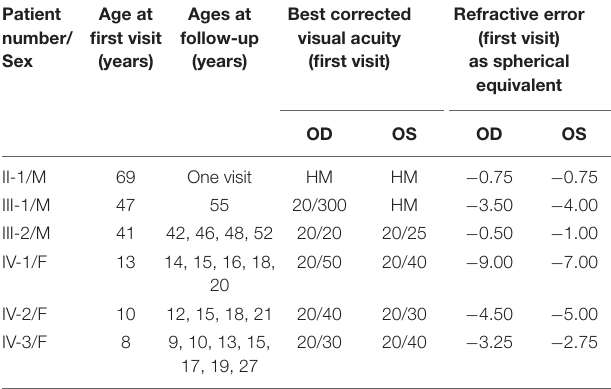
TABLE 1 | Clinical characteristics of ARL3